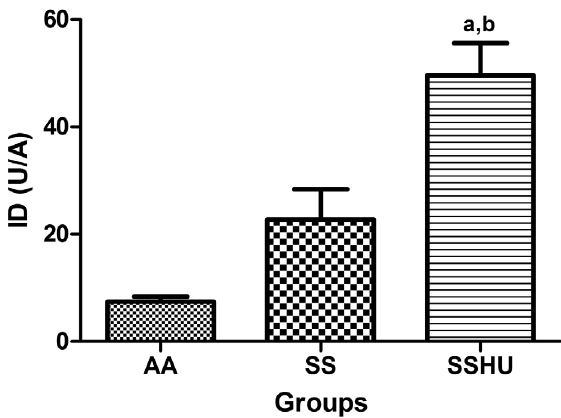
FIGURE 1 – Influence of treatment with HU on the DI values in neutrophils from patients with sickle cell anaemia. AA: Control group (healthy individuals) (n=52); SS: patients with sickle cell anaemia not treated with HU (n=20); SSHU: patients with sickle cell anaemia treated with HU (n=21). Results were expressed as mean ± SEM. ANOVA followed by turkey posttest. a p0.05 versus AA group. b 0.05 versus SS